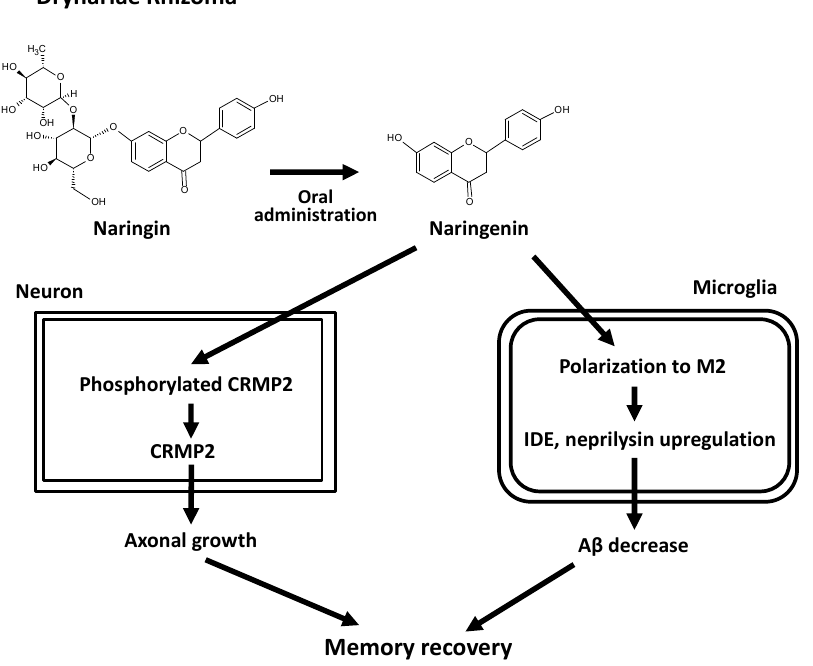
Figure 4. Mechanisms of memory recovery induced by Drynariae Rhizoma extract in Alzheimer’s disease models [80,91].